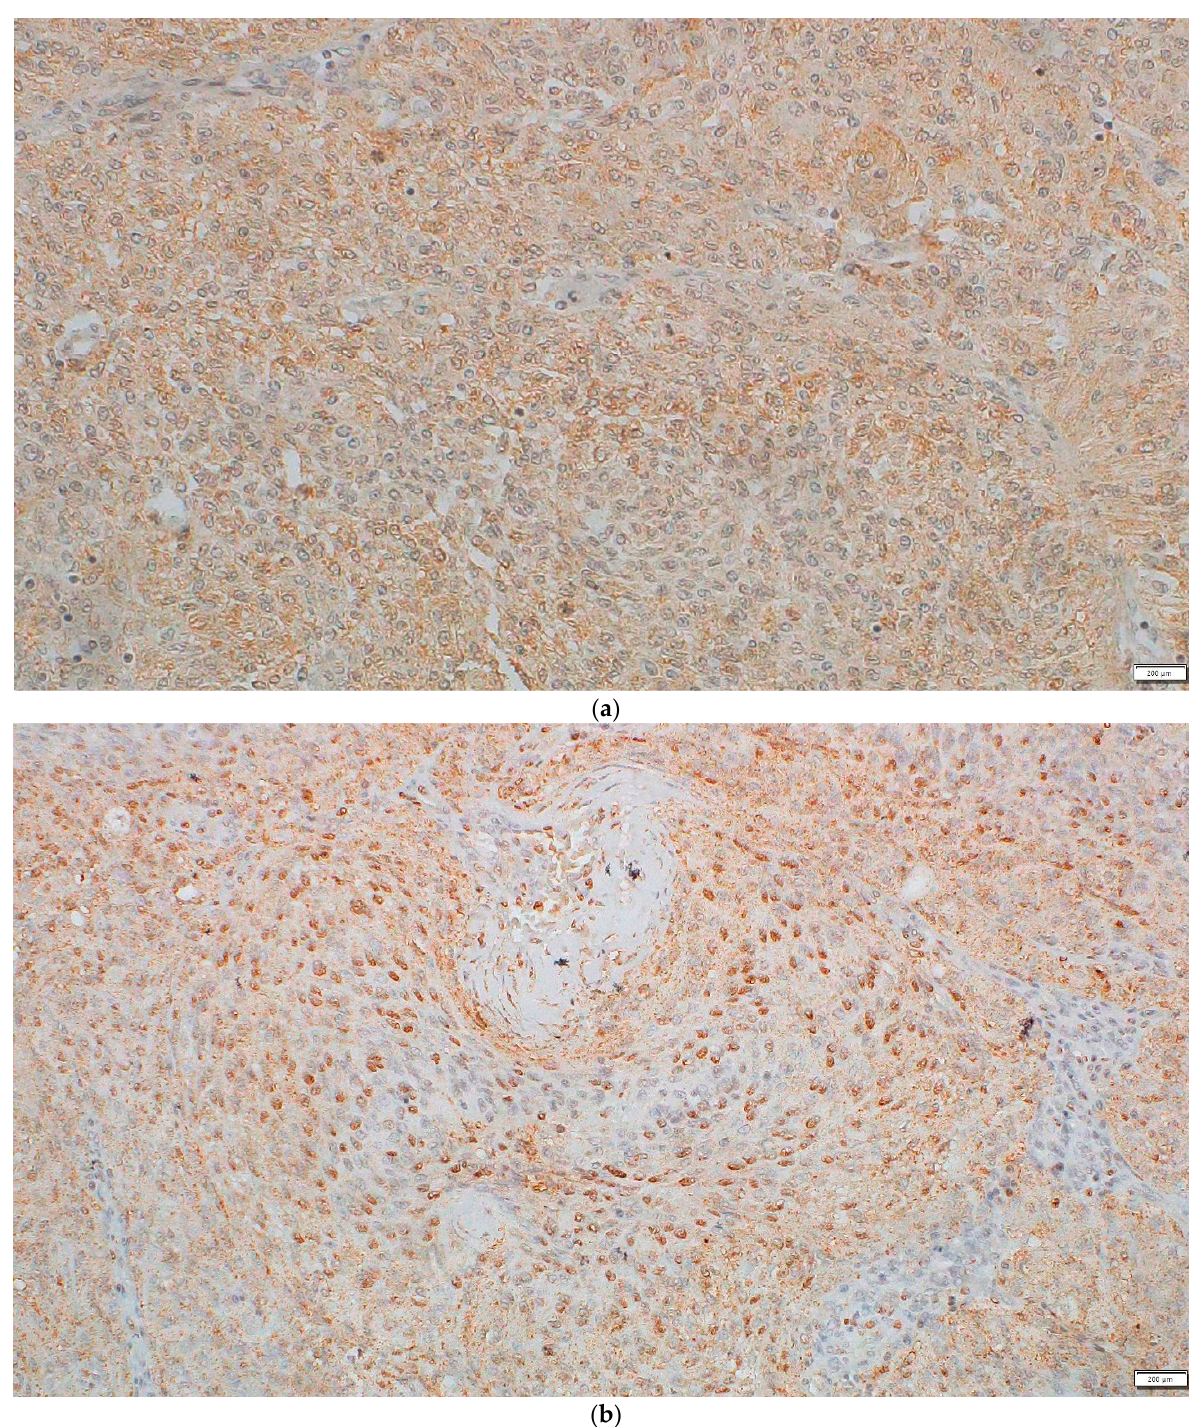
Figure 3. ( a ) Cytoplasmic localization of DVL1 in intracranial meningioma, with moderate to high expression. The speci- men was taken from a 70-year-old female patient who was diagnosed with atypical (grade II) meningioma. ( b ) Nuclear localization of DVL1 in intracranial meningioma, with high expression. The specimen was taken from a 58-year-old female patient who was diagnosed with atypical (grade II) meningioma. Magnification: 200×, scale bar: 200 μ m.